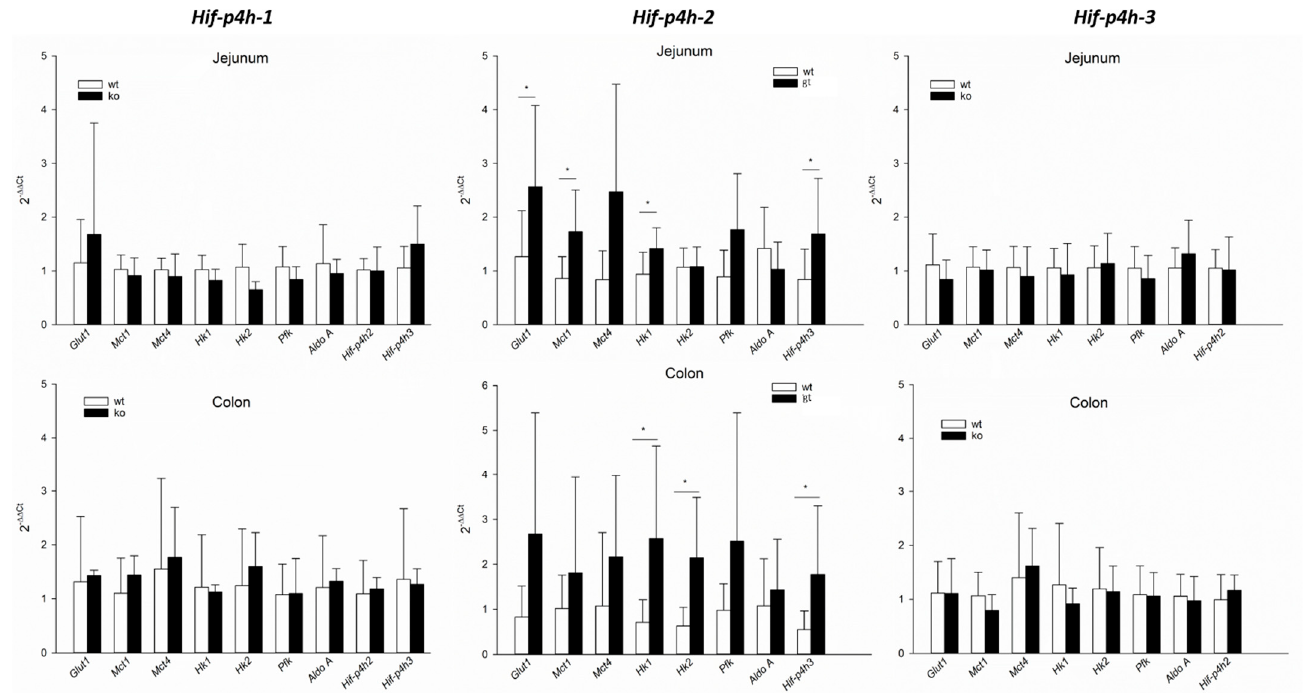
Figure 4. Analysis of HIF target gene expression in the gastrointestinal epithelium of Hif-p4h gene-modified mice. mRNA expression levels of selected HIF target genes were analysed by RT-qPCR in the jejunum (upper panel) and colon (lower panel) epithelium of Hif-p4h-1 − / − , Hif-p4h-2 gt/gt and Hif-p4h-3 − / − mice (black bars) relative to their wild-type littermates (white bars). Data are presented as means ± SD, Student’s t-test, asterisks indicate a significant difference when compared to the wild type, * p < 0.05. n = 5 Hif-p4h-1 +/+ and 9 Hif-p4h-1 − / − jejunum, 2 Hif-p4h-1 +/+ and 5 Hif-p4h-1 − / − colon, 8 Hif-p4h-2 +/+ and 9 Hif-p4h-2 gt/gt jejunum, 7 Hif-p4h-2 +/+ and Hif-p4h-2 gt/gt colon, and 8 Hif-p4h-3 +/+ and Hif-p4h-3 − / − jejunum and colon.